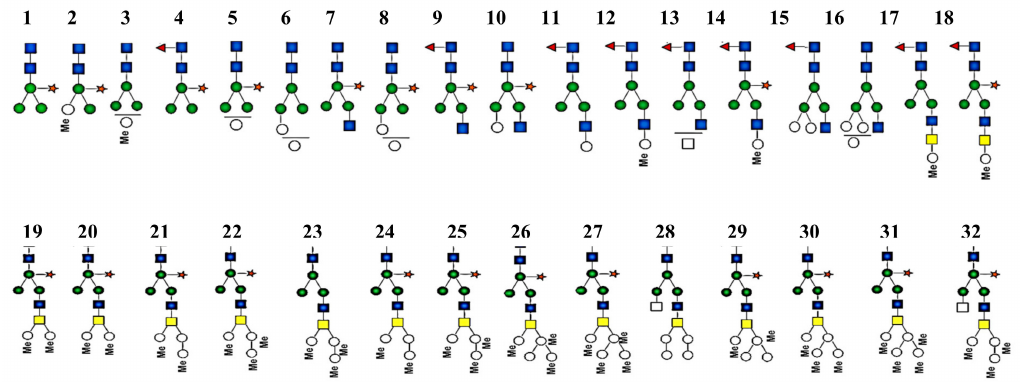
Figure 10. Neutral N -attached glycans from β c- Н l Н , obtained after treatment with PNGase. Monosaccharides, presented through nomenclature of the consortium of functional